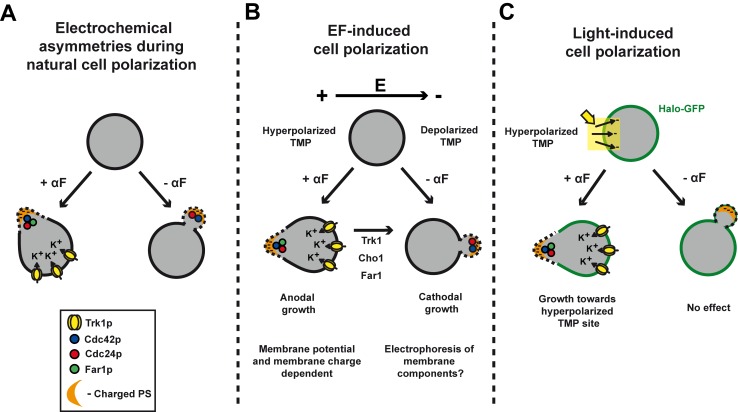
Influence of electrochemical asymmetries on polarity.(A) During normal cell polarization, electrochemical layers segregate to the front and the back of the cell and may influence polarization processes, for instance during mating. (B) In an EF, the anode-facing side has hyperpolarized membrane potential, which drives anodal growth of the shmoos, in a Trk1-, Cho1-, and Far1-dependent manner. The secondary default orientation mode appears to be the cathodal orientation, which drives bud emergence and shmoo growth in trk1Δ, cho1Δ, and far1-s mutants by a yet unknown mechanism. (C) Optogenetic experiments directly suggest that local hyperpolarization of cell membrane potential can drive shmoo polarized growth but not bud site emergence. αF, α-factor.